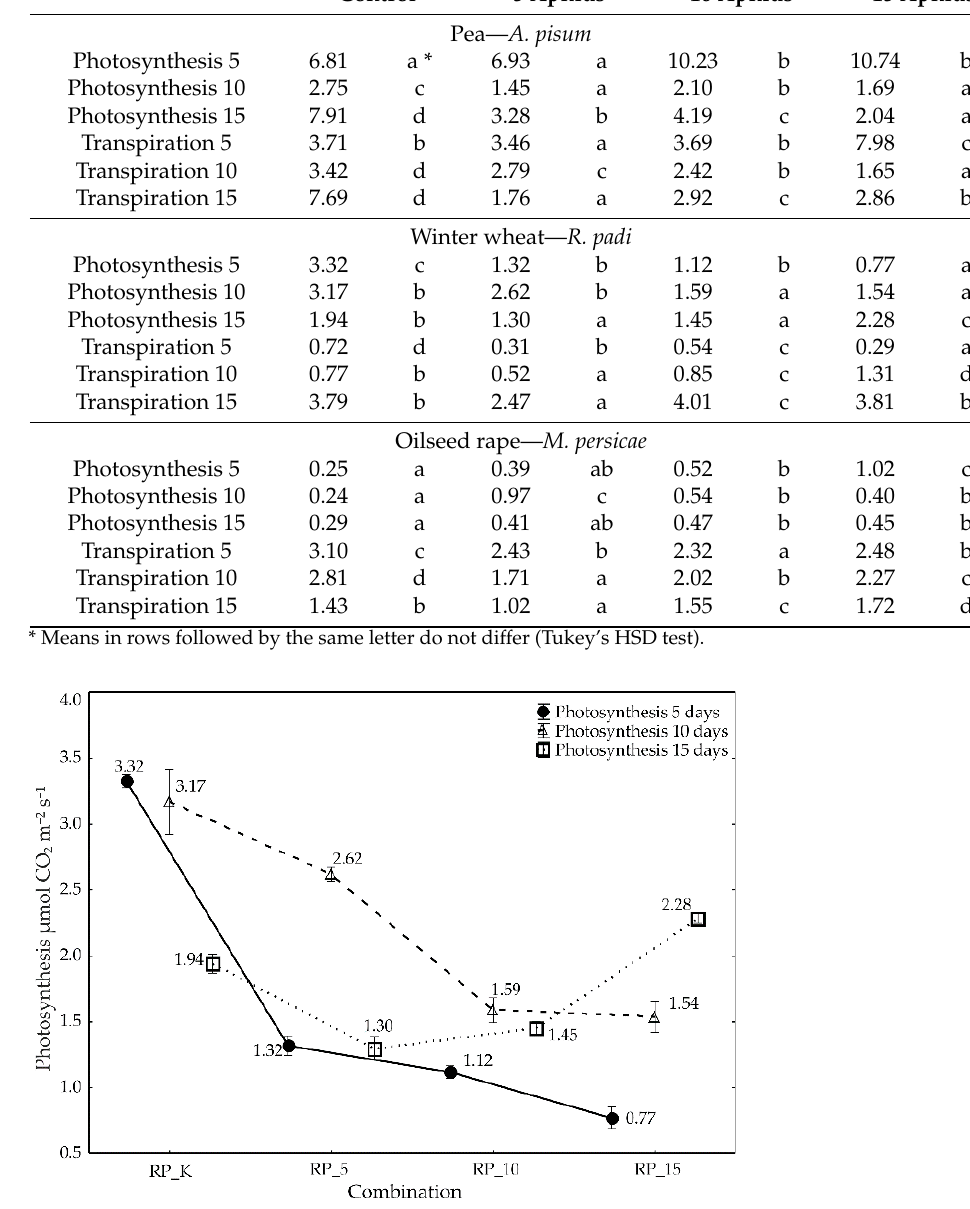
revealed homogenous clusters relative to the intensity of photosynthesis between the control and the variant with 5 aphids on the 10th day of the experiment (Table